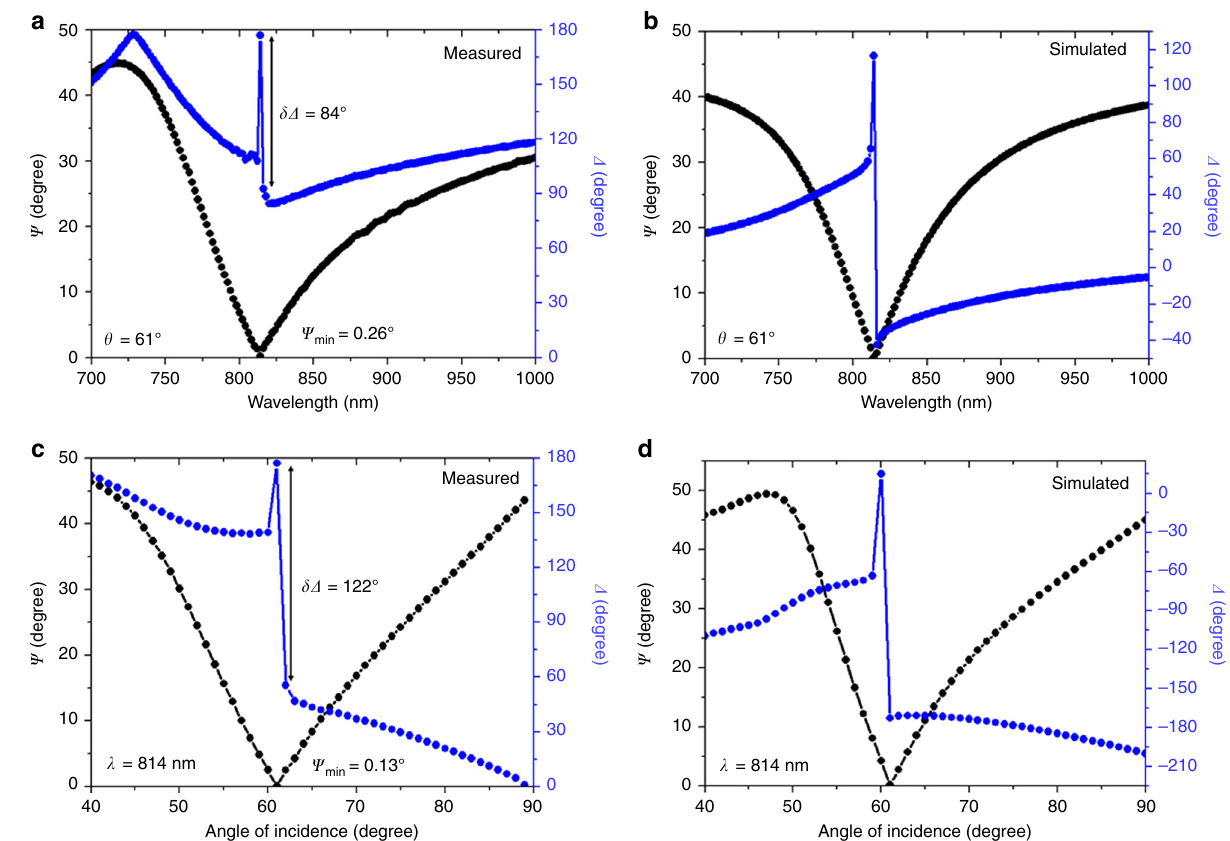
Fig. 2 Demonstration of the point of darkness and singular phase using the longer wavelength mode. a Measured and b calculated pair of ellipsometry parameters as a function of wavelength at the angle of incidence of 61°. c Measured and d calculated pair of ellipsometry parameters as a function of incident angle at a wavelength of 814 nm. The ψ min and phase singularity are exactly obtained at 61° and 814